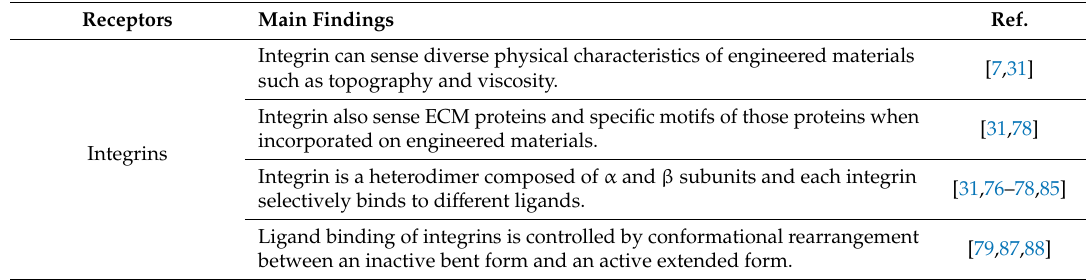
Table 6. Receptors sensing various physical